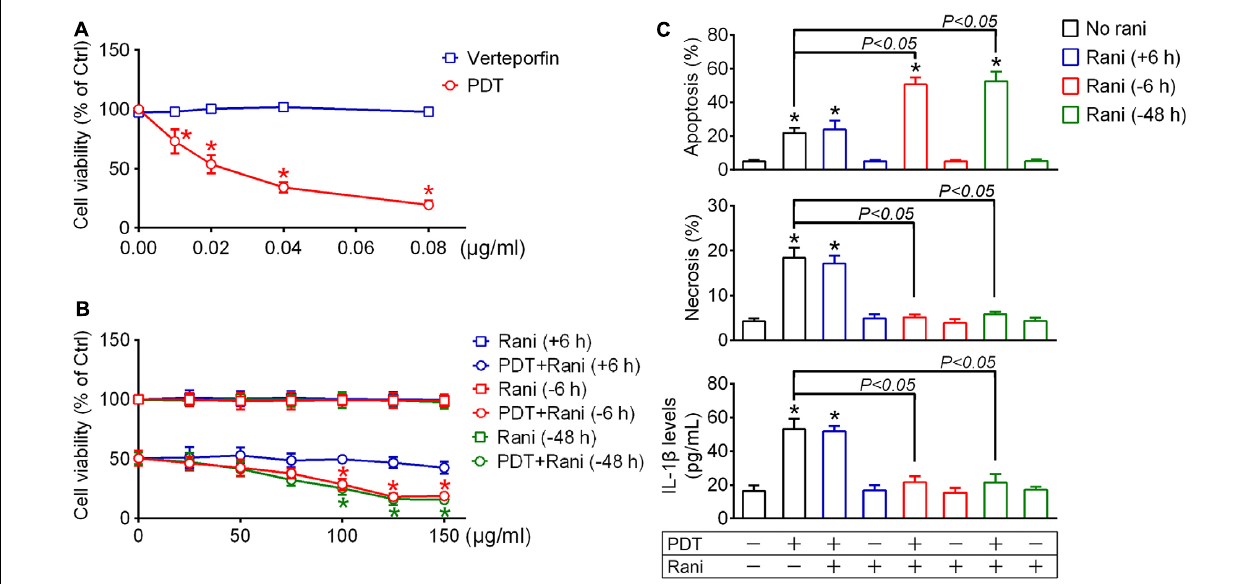
FIGURE 1 | Pre-compared to post-treatment with ranibizumab (rani) aggravates photodynamic therapy (PDT) injury and alleviates inflammatory response in RF/6A cells. (A) For PDT treatment, RF/6A cells were treated with different doses of the photosensitizer verteporfin (0.01, 0.02, 0.04, and 0.08 µ g/mL) for 10 min prior to irradiation with 689 nm laser (50 J/cm 2 ) for 83 s. Cell viability was measured at 12 h using CCK-8 assay. (B) The anti-vascular endothelial cell growth factor (VEGF) antibody rani of various final concentrations (0, 25, 50, 75, 100, 125, and 150 µ g/mL) were applied to PDT-exposed cells or normal cells at different time points [6, 48 h before PDT (-6, -48 h) or 6 h after PDT (+6 h)], and cell viability was also detected at 12 h after PDT. n = 4; * P < 0.05, compared with the control at 0 µ g/mL in the same group. (C) Rani (125 µ g/mL) was applied to PDT-exposed cells or normal cells at different time points (+6, -6, -48 h), and cell apoptosis and necrosis were determined by flow cytometry at 12 h after PDT while IL-1 β protein levels in culture medium supernatants were measured via ELISA. n = 4; * P < 0.05, compared with the